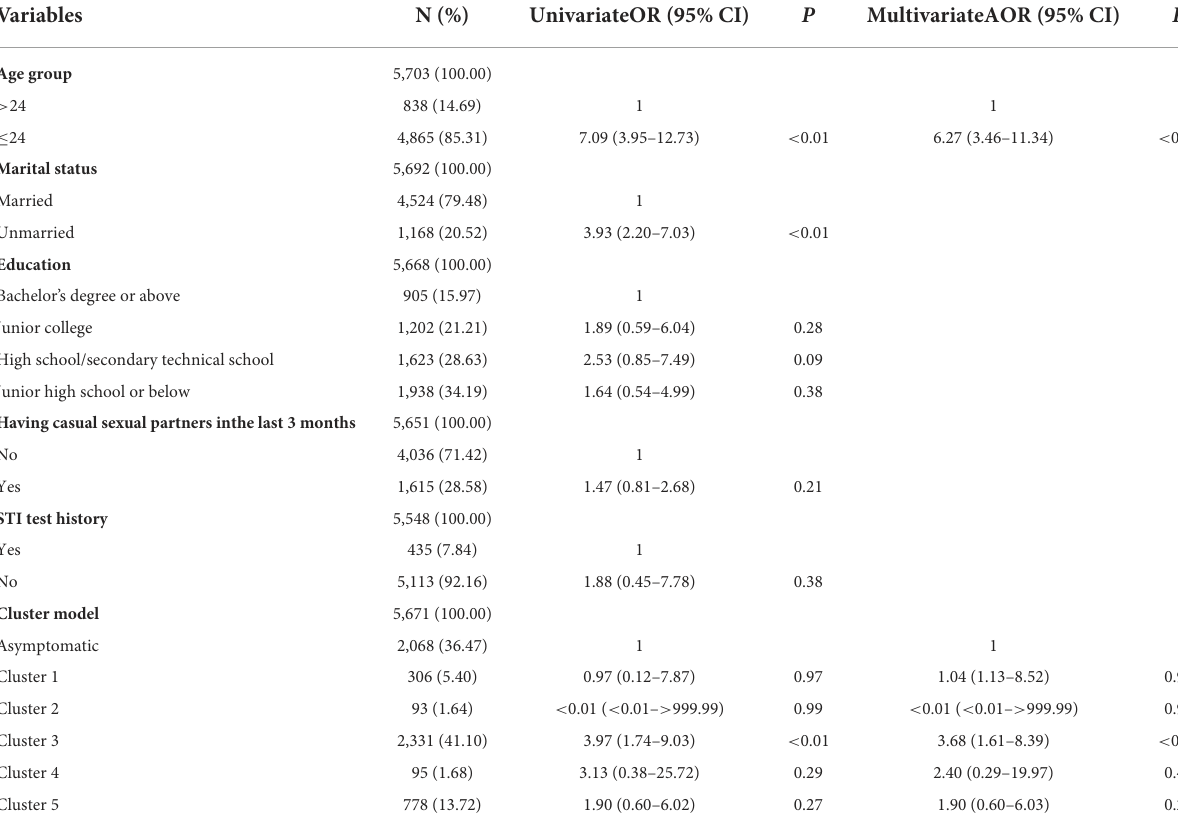
TABLE 5 Univariate and multivariate logistic regression analyses of factors associated with NG in